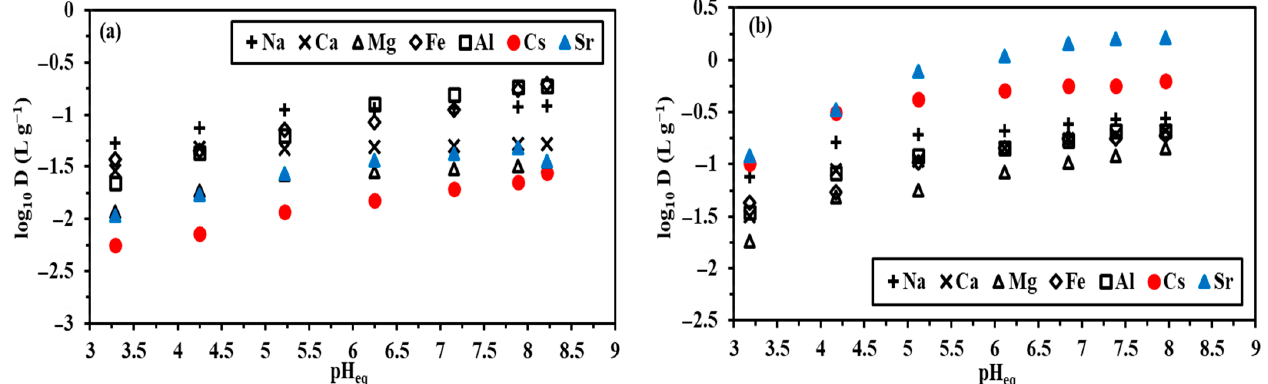
Figure A16. Metal sorption from multicomponent solutions using ALG-PEI ( a ) and APO-PEI ( b ) sorbents: effect of pH eq on log 10 D vs. pH eq (C 0 , mmol L − 1 : 0.883 Na(I), 0.530 Ca(II), 1.020 Mg(II), 0.881